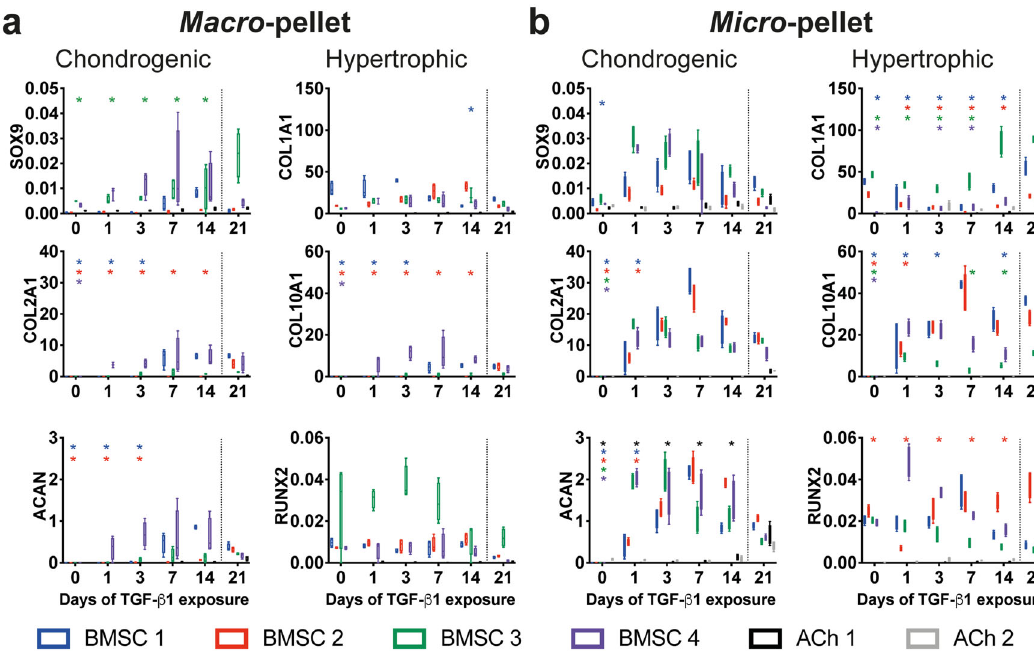
Fig. 4 qPCR analysis of cartilage-like tissues derived from BMSCs or ACh on day 21 of culture, following varying days of TGF- β 1 exposure. a qPCR from macro -pellet cultures, b qPCR from micro -pellet cultures. All values are compared with the standard 21 days of TGF- β 1 exposure control (separated by the dotted line). Gene expression values represent 2 − Δ Ct , normalized to GAPDH . Asterisks are shown for values that are signi fi cantly lower than the corresponding 21 days of TGF- β 1 exposure control. Box plots: n = 4 for each donor; * P < 0.05.